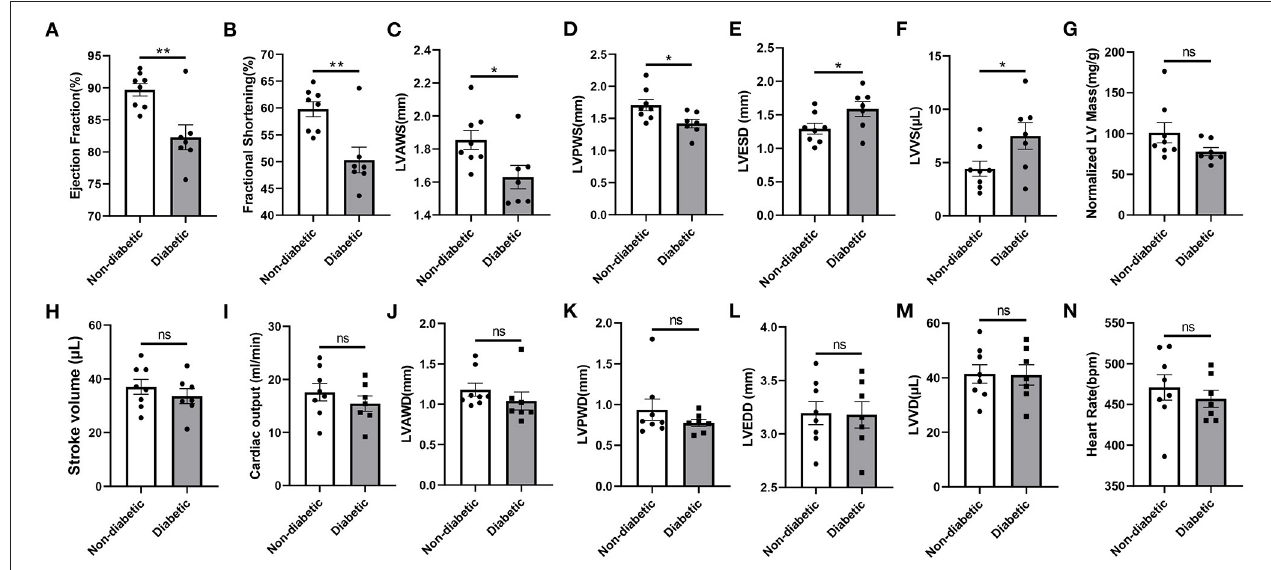
FIGURE 6 | Echocardiographic properties in non-diabetic and STZ-induced diabetic mice. (A) Ejection fraction; (B) Fractional shortening; (C) Left ventricular (LV) anterior wall thickness in systole; (D) LV posterior wall thickness in systole; (E) LV end-systolic diameter; (F) LV volumes in systole; (G) LV mass normalized to body weight; (H) Stroke volume; (I) Cardiac output; (J) LV anterior wall thickness in diastole; (K) LV anterior posterior wall thickness in diastole; (L) LV end-diastolic diameter; (M) LV volumes in diastole; (N) Heart rate. Mean ± SEM, n = 7–8 mice per group. * p < 0.05 and ** p < 0.01 vs. Non diabetic control group. ns, no significance.